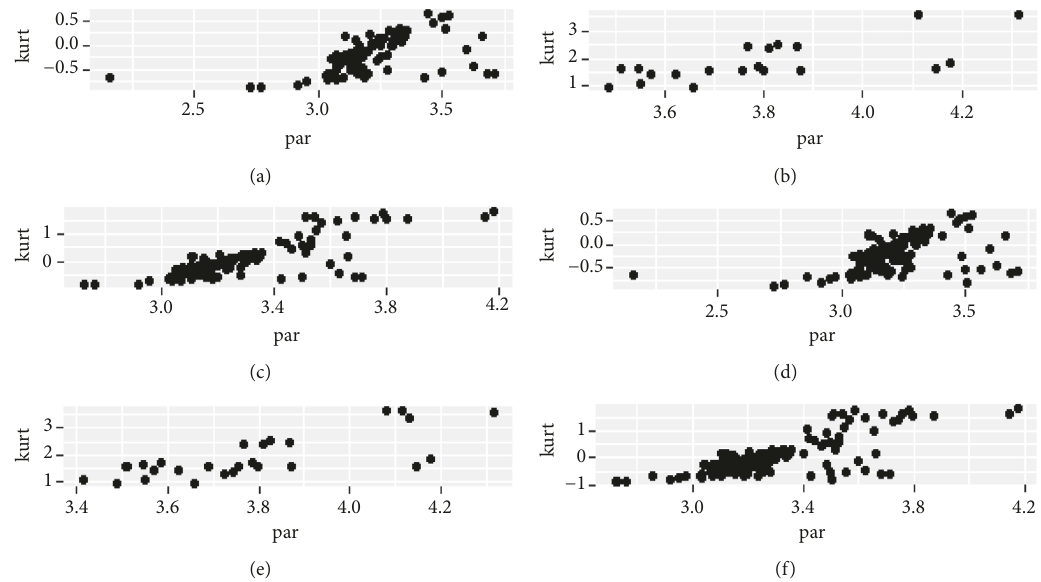
Figure 5: (a) The class I of Clara clustering of T sets. (b) The class I of Kmeans clustering of T sets. (c) The class I of Dbscan clustering of T sets. (d) The class I of Clara clustering of F sets. (e) The class I of Kmeans clustering of F sets. (f) The class I of Dbscan clustering of F sets.